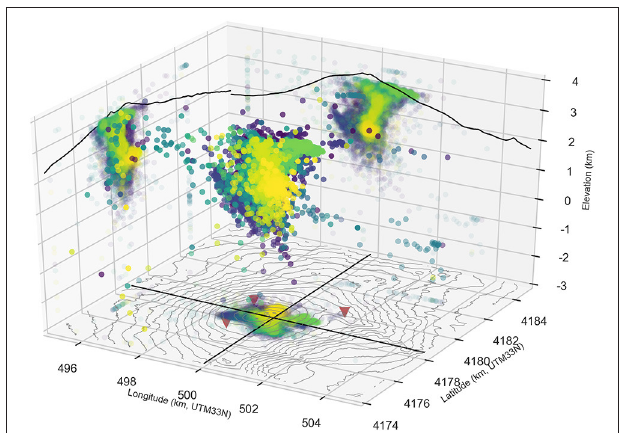
FIGURE 5 | Location of volcanic tremor centroids during study period from near real-time processing. The color refers to the temporal evolution presented in Figure 6 , X and Y are the longitude and the latitude in km UTM zone 33N, respectively, and Z is the altitude in km above sea level.